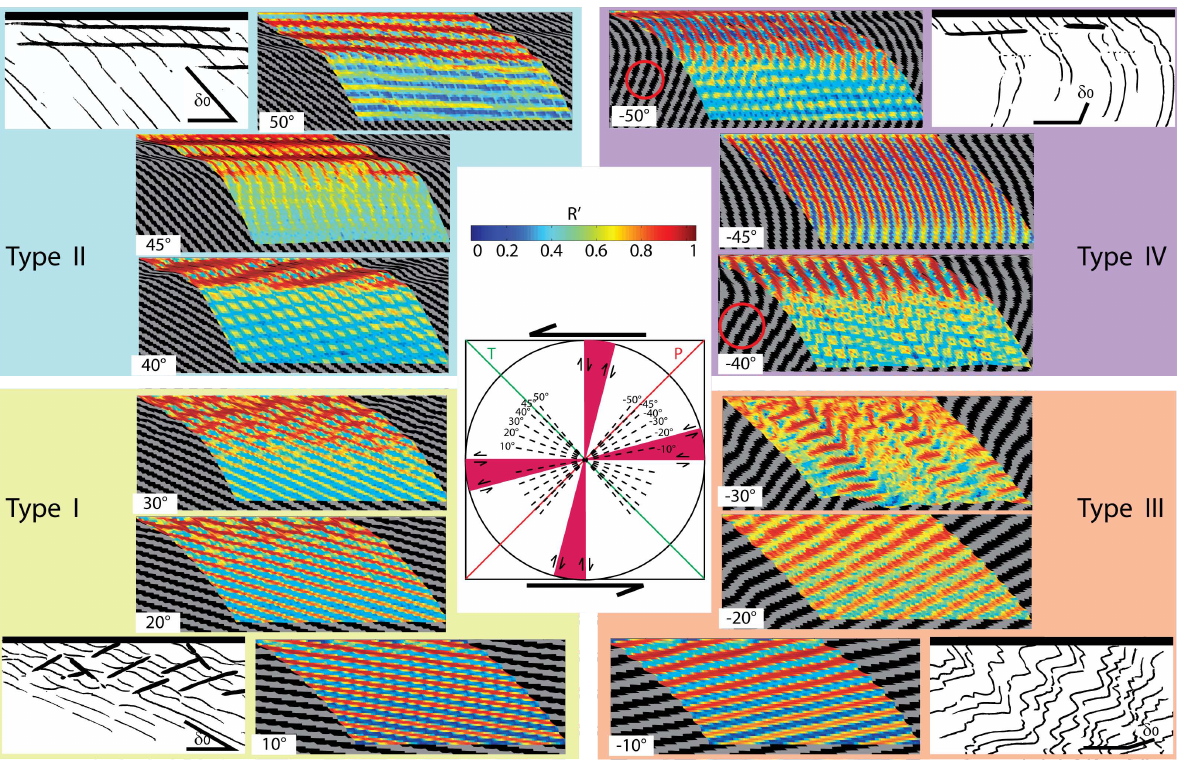
Fig. 3. Results of the parametric study at γ = 1, accompanied by sketches of results. Black and grey indicate, respectively, the location of weak and strong layers; colour scale indicates strain intensity. Red circles refer to specific structures described in the text. P and T are the instantaneous shortening and stretching axis at large scale, respectively. Maximum large-scale shear directions are indicated in